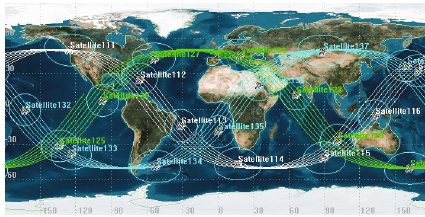
Figure 13: The coverage of COF.